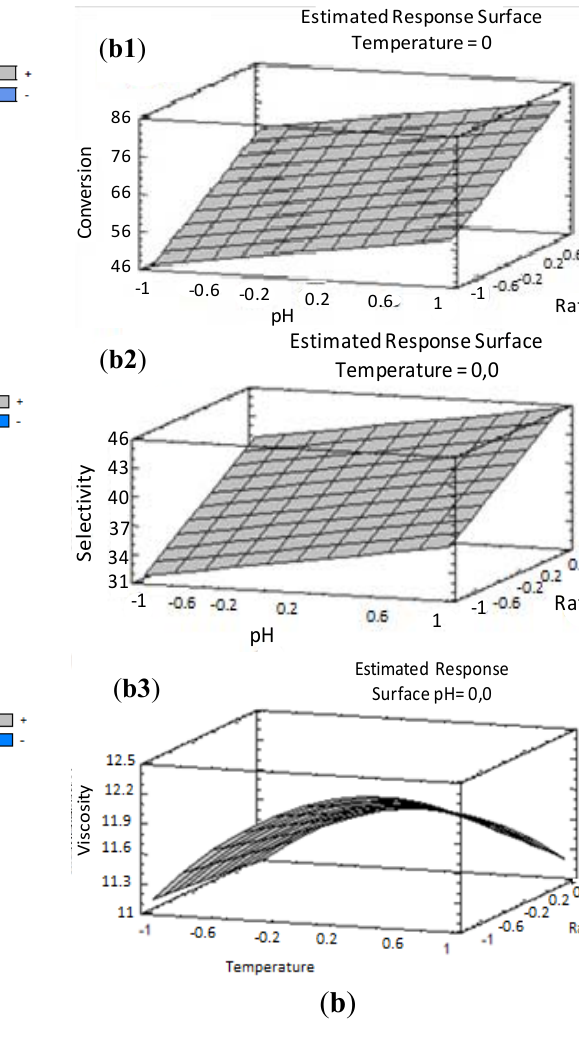
Figure 4. Pareto graphics ( a ): Conversion ( a1 ); Selectivity ( a2 ) and Viscosity ( a3 ); As well as response surface plot of more influential parameters vs . pH, Temperature and